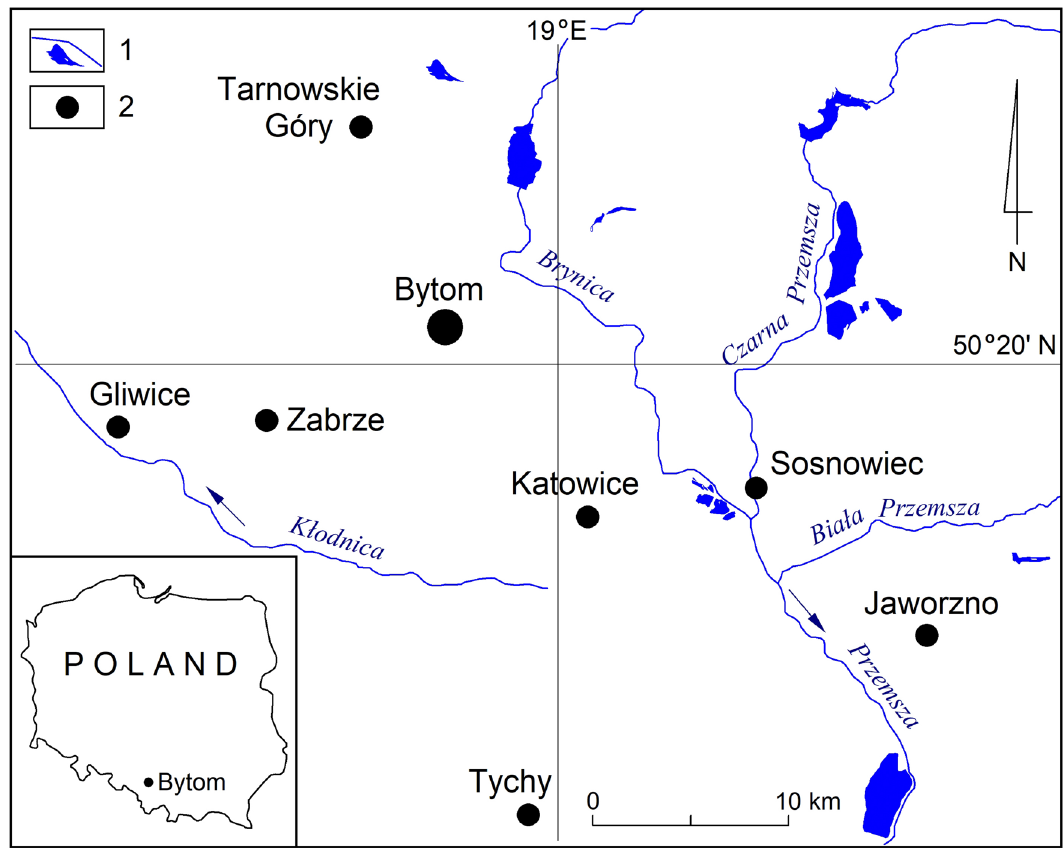
Figure 1. Study area location: 1—water courses and water reservoirs; 2—major